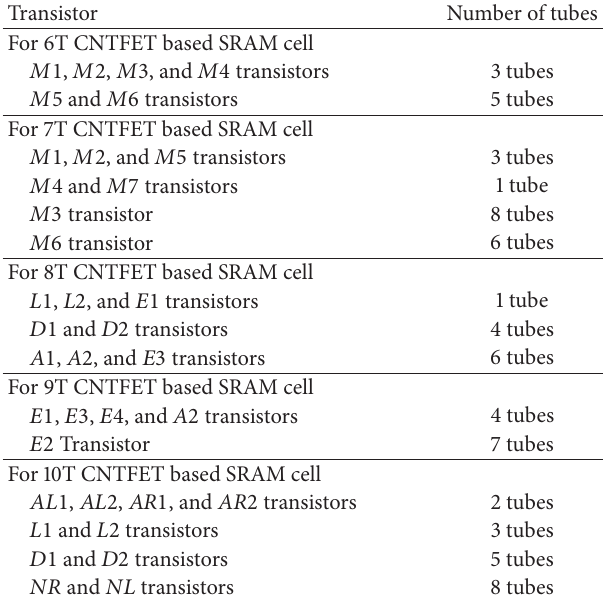
shown in Figure 6.